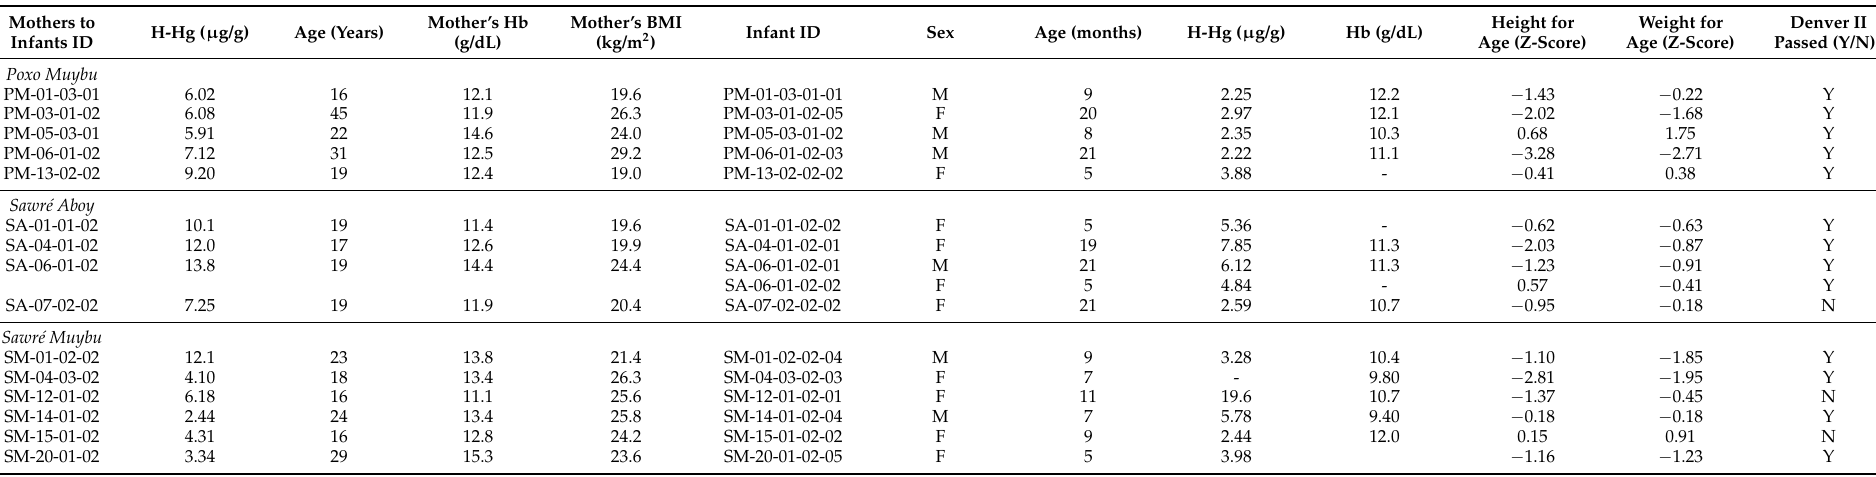
Table 1. Demographic (sex and age) and clinical (methylmercury and hemoglobin levels, as well nutritional status) characteristics of mothers and their children under 2 years, Sawr é Muybu Indigenous Land, Brazilian Amazon,